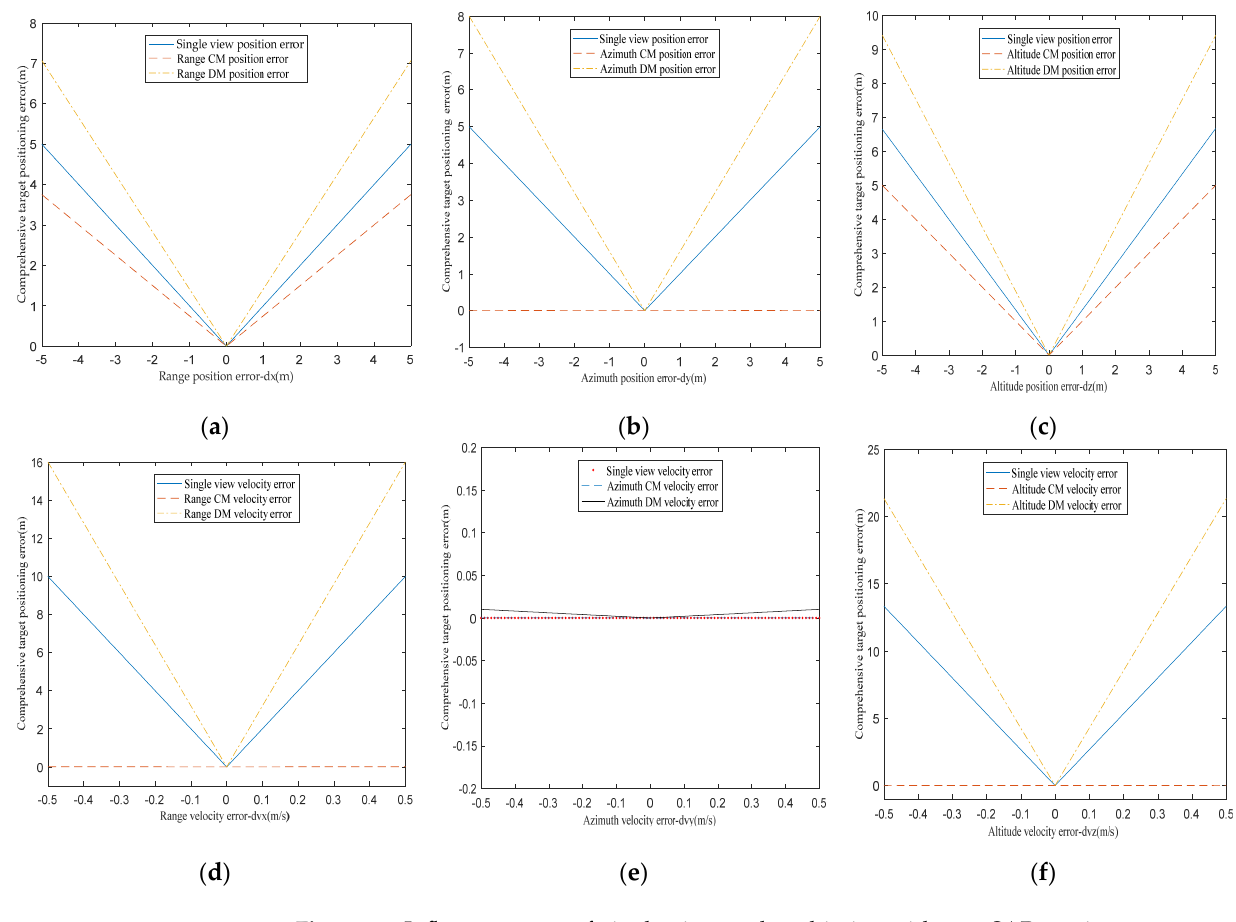
Figure 3. Influence curve of single-view and multi-view airborne SAR motion error on target positioning error. ( a – c ) Influence of aircraft position error in range, azimuth and altitude on target positioning error. ( d – f ) Influence of aircraft velocity error in range, azimuth and altitude on target positioning error.